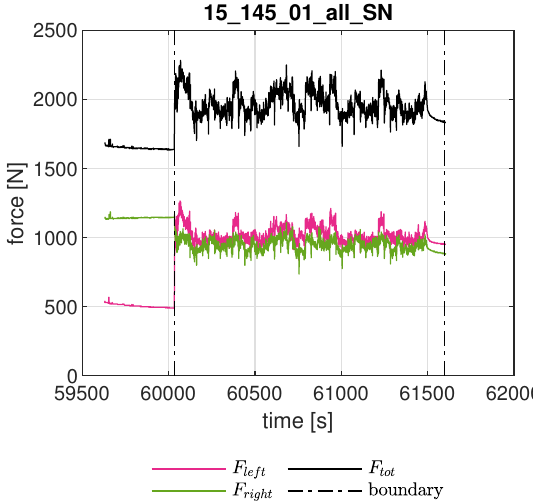
Figure 4: Left, right and summed force acting on roller 01 on panel 145. The boundary indicates start and end of measurement.